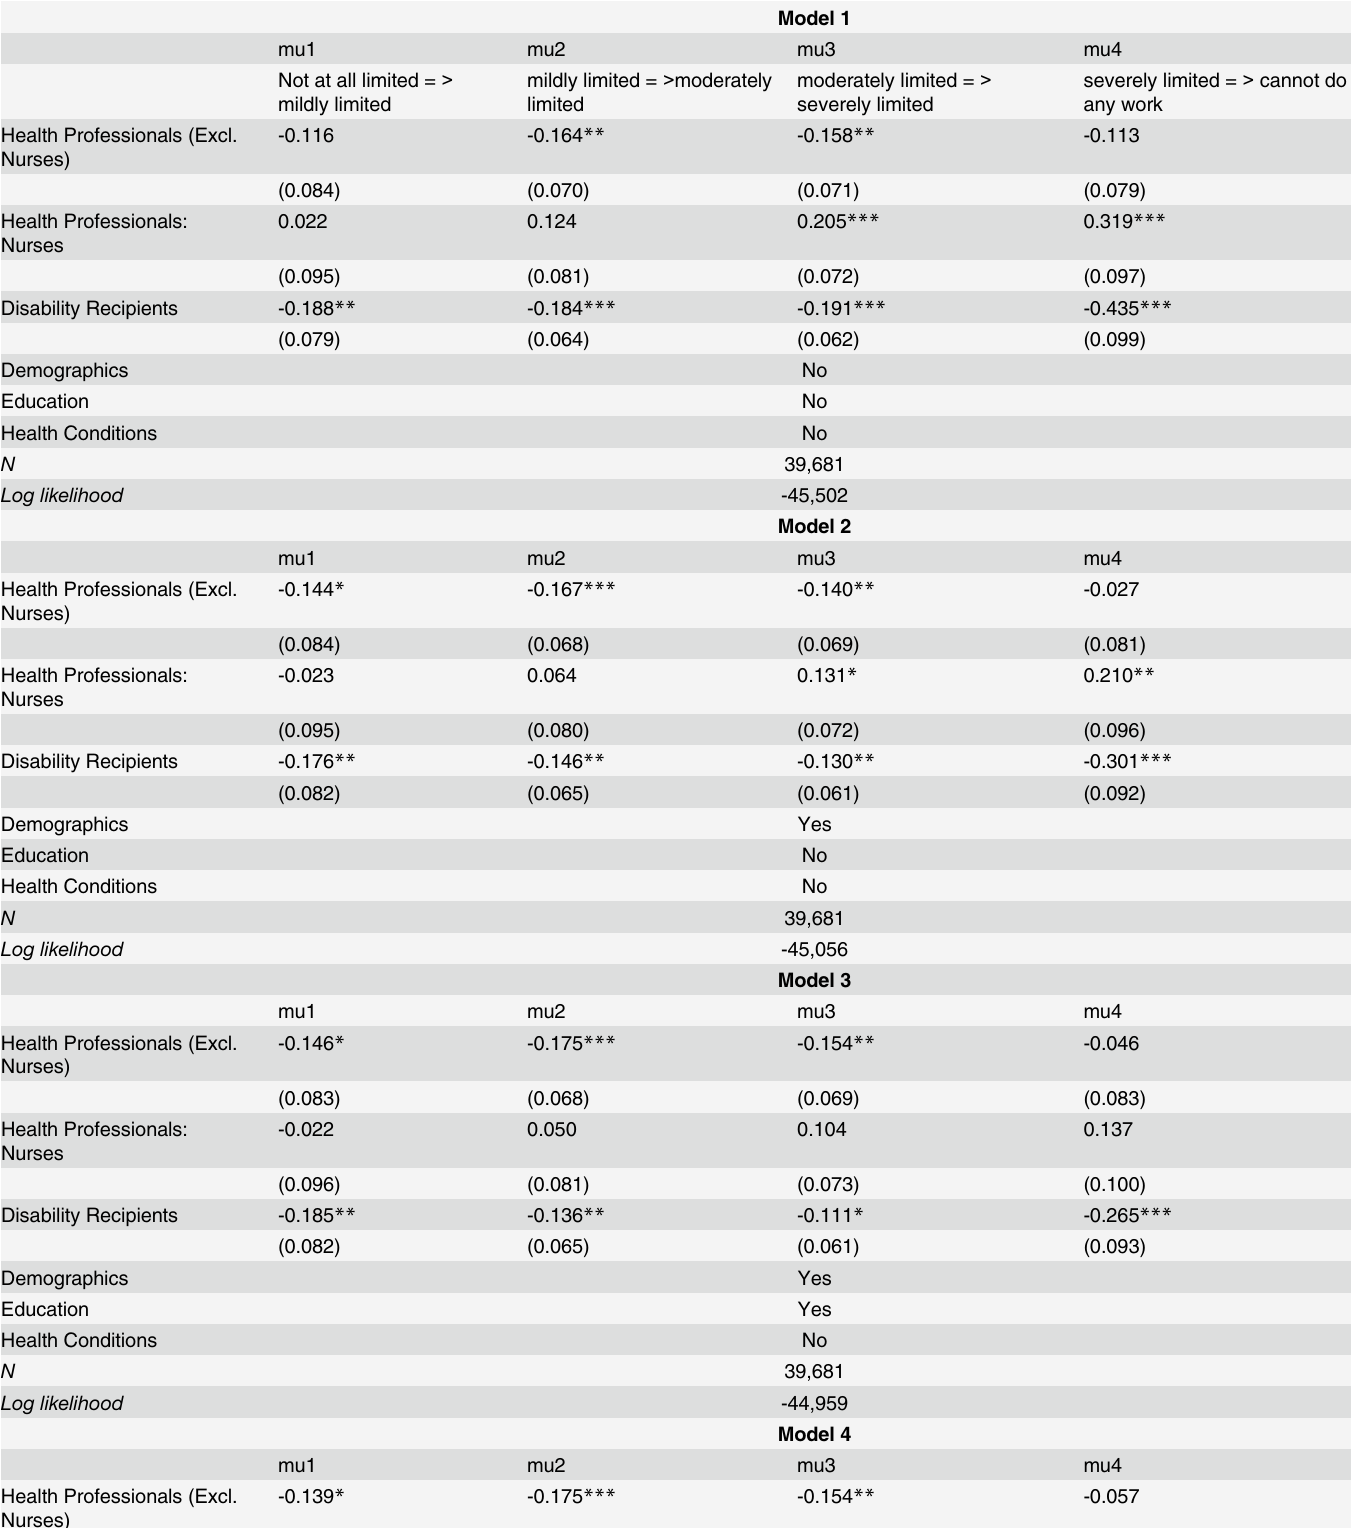
Table 2. Estimation Results in Generalized Ordered Probit Model of Respondents' Rating of Vignettes' Work